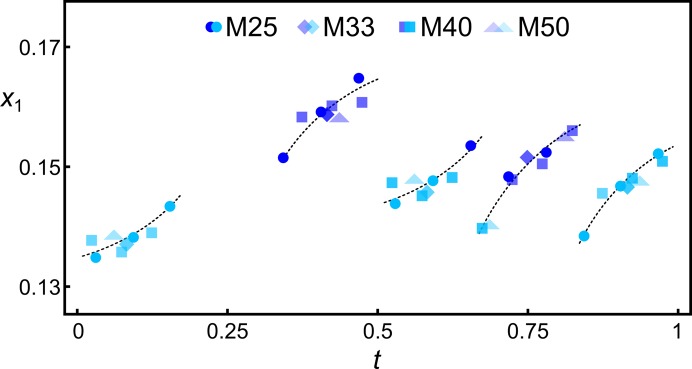
Coordinate x
1 of tetrahedral Al2 (light blue) and Si2 (dark blue) atoms of geometrically optimized (PBE) superstructures with labels M25 #2 (circles), M33 #1 (diamonds), M40 #1 (squares) and M50 #1 (triangles). The displacive and occupational modulation functions follow the same trend, allowing a description of the solid solution range by a unified superspace model. Dashed lines indicate trend lines fitted by hand.